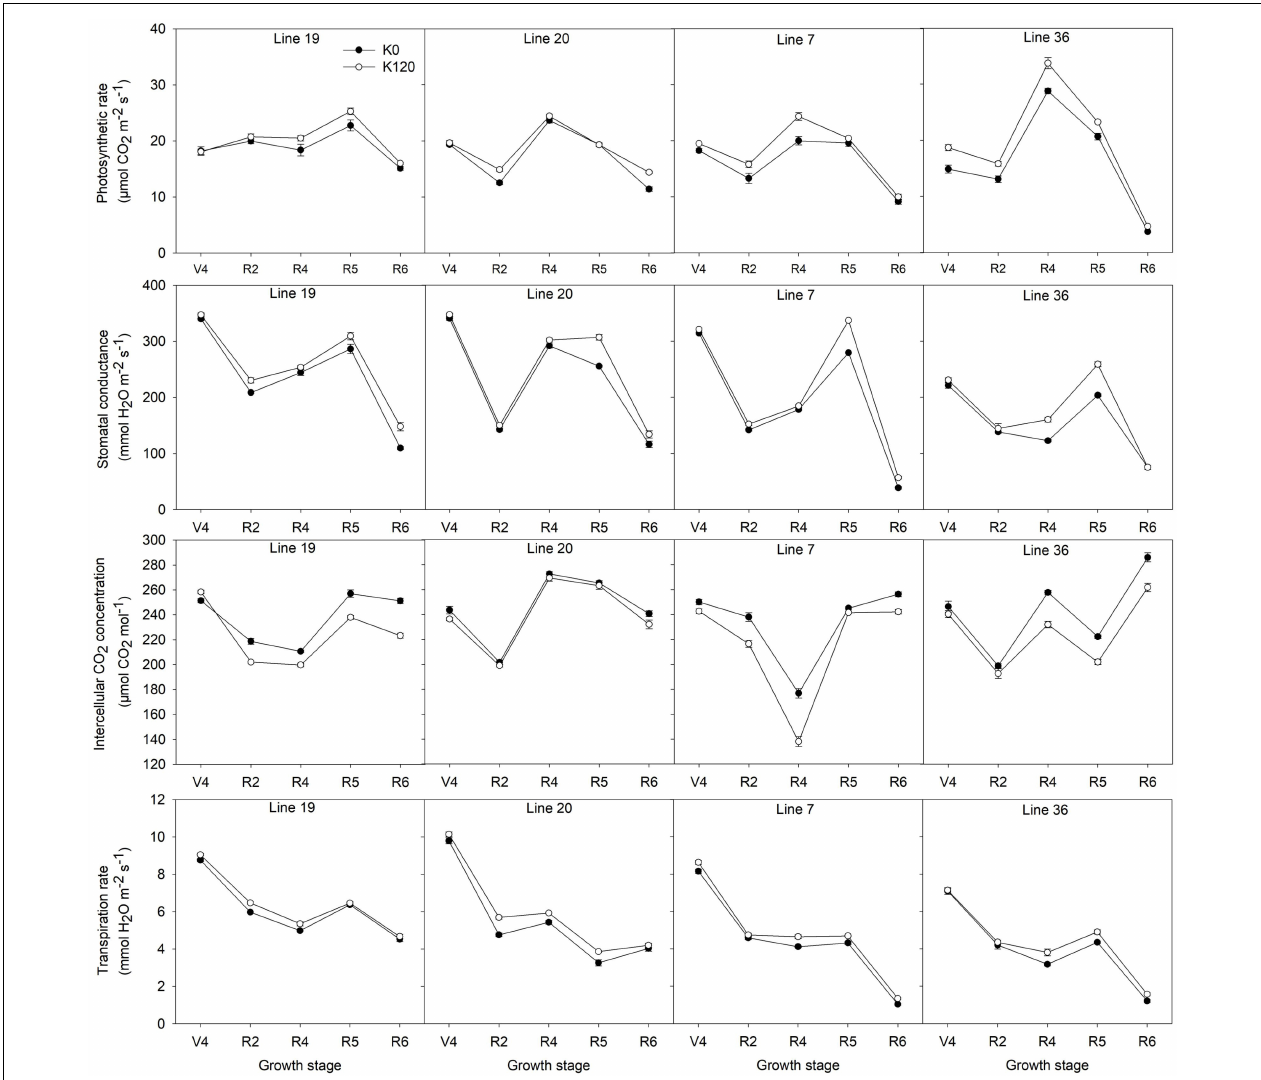
FIGURE 4 | Changes of the photosynthetic parameters of vegetable soybean genotypes with different K efficiency in a pot experiment. Values are means of three replicates ± SE.